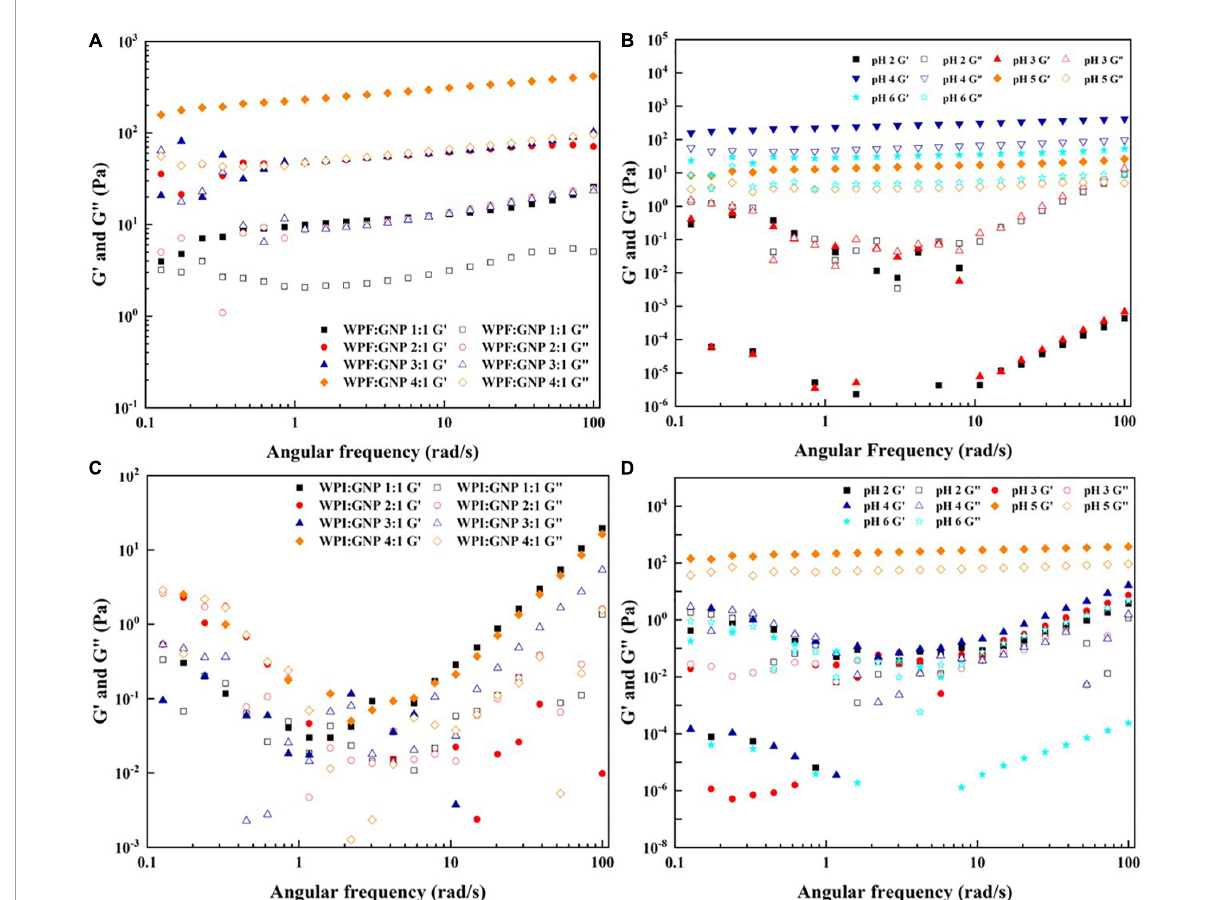
FIGURE5 Frequency sweep of WPF-GNP hydrogel at various protein ratio (A) and pH values (B) ; Frequency sweep of WPI-GNP hybrids at various protein ratio (C) and pH values (D)